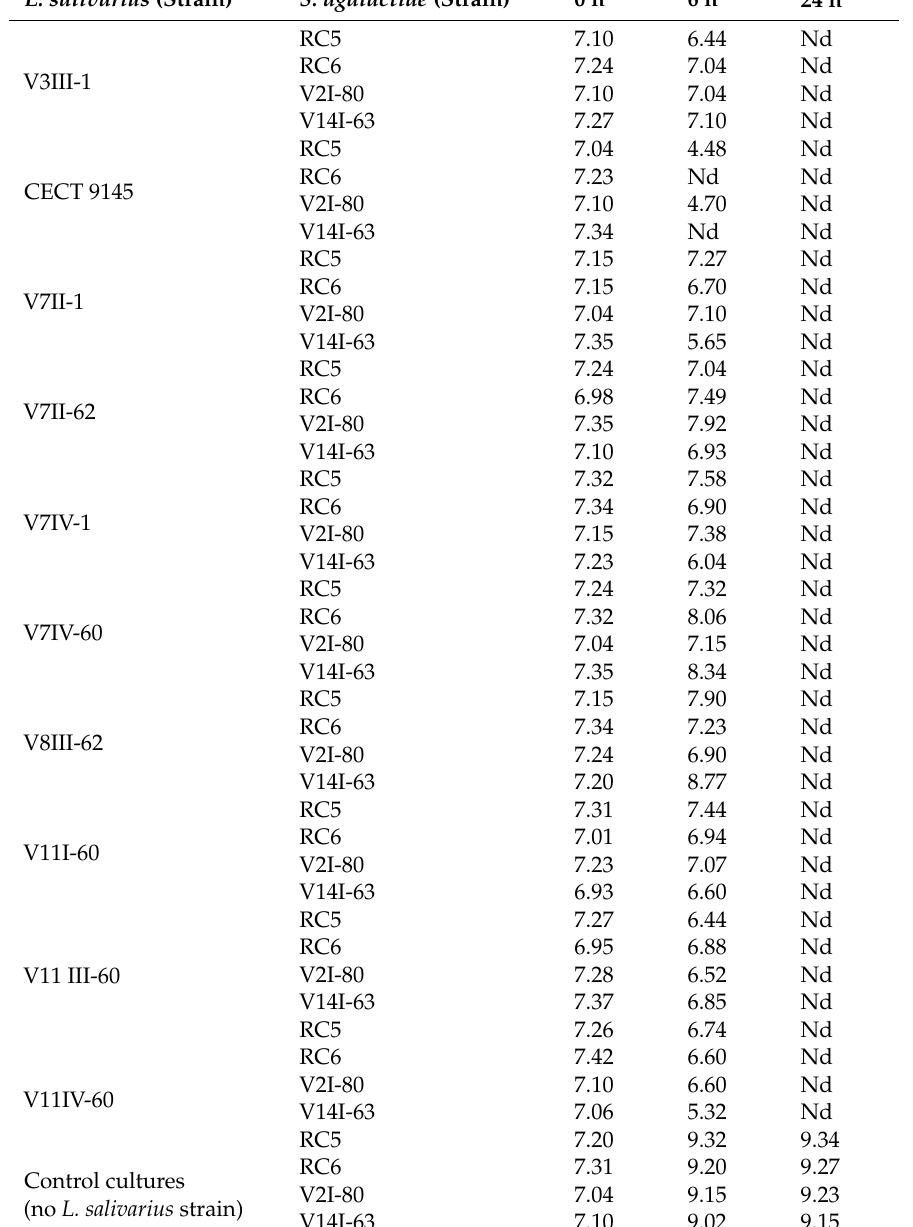
Table 2. The bacterial counts (log 10 cfu/mL) of the S. agalactiae strains when co-cultured with the L. salivarius strains in MRS broth for 0, 6 and 24 h at 37 ◦